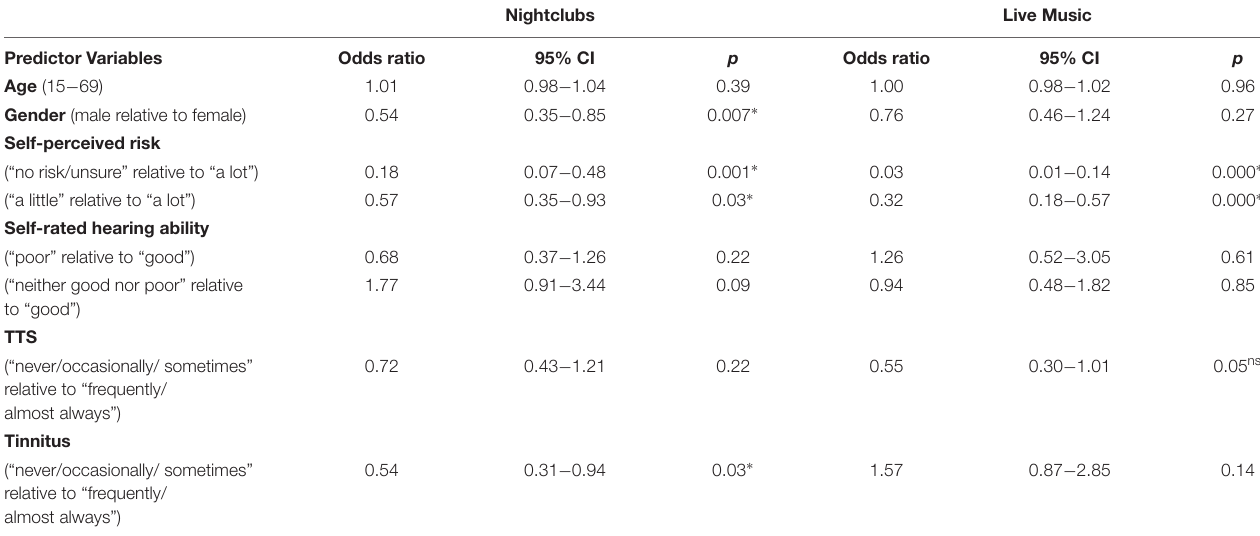
FIGURE 3 | Participants’ mean estimated sound levels for live music venues and nightclubs. Typical = typical sound levels, Pref-S = preferred sound levels, Pref-O = Others’ preferred sound levels. Errors bars = + / − 1 standard deviation.